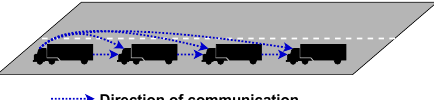
Figure 6. Predecessor-leader following topology of platooning communications.